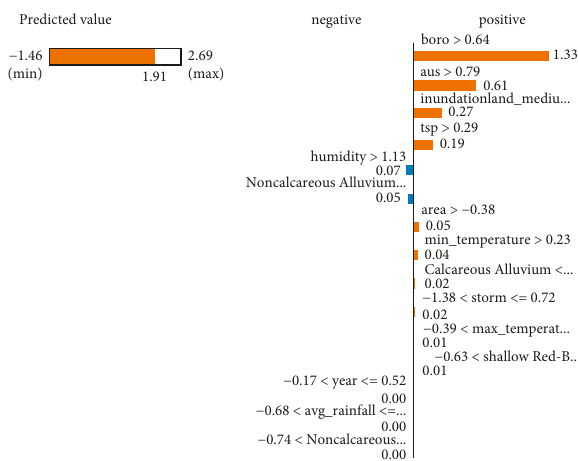
Figure 21: A plot of LIME model values for the SVR model and Aman yield data. Table 6: The exact value and the predicted value of Boro yield in the different districts in different